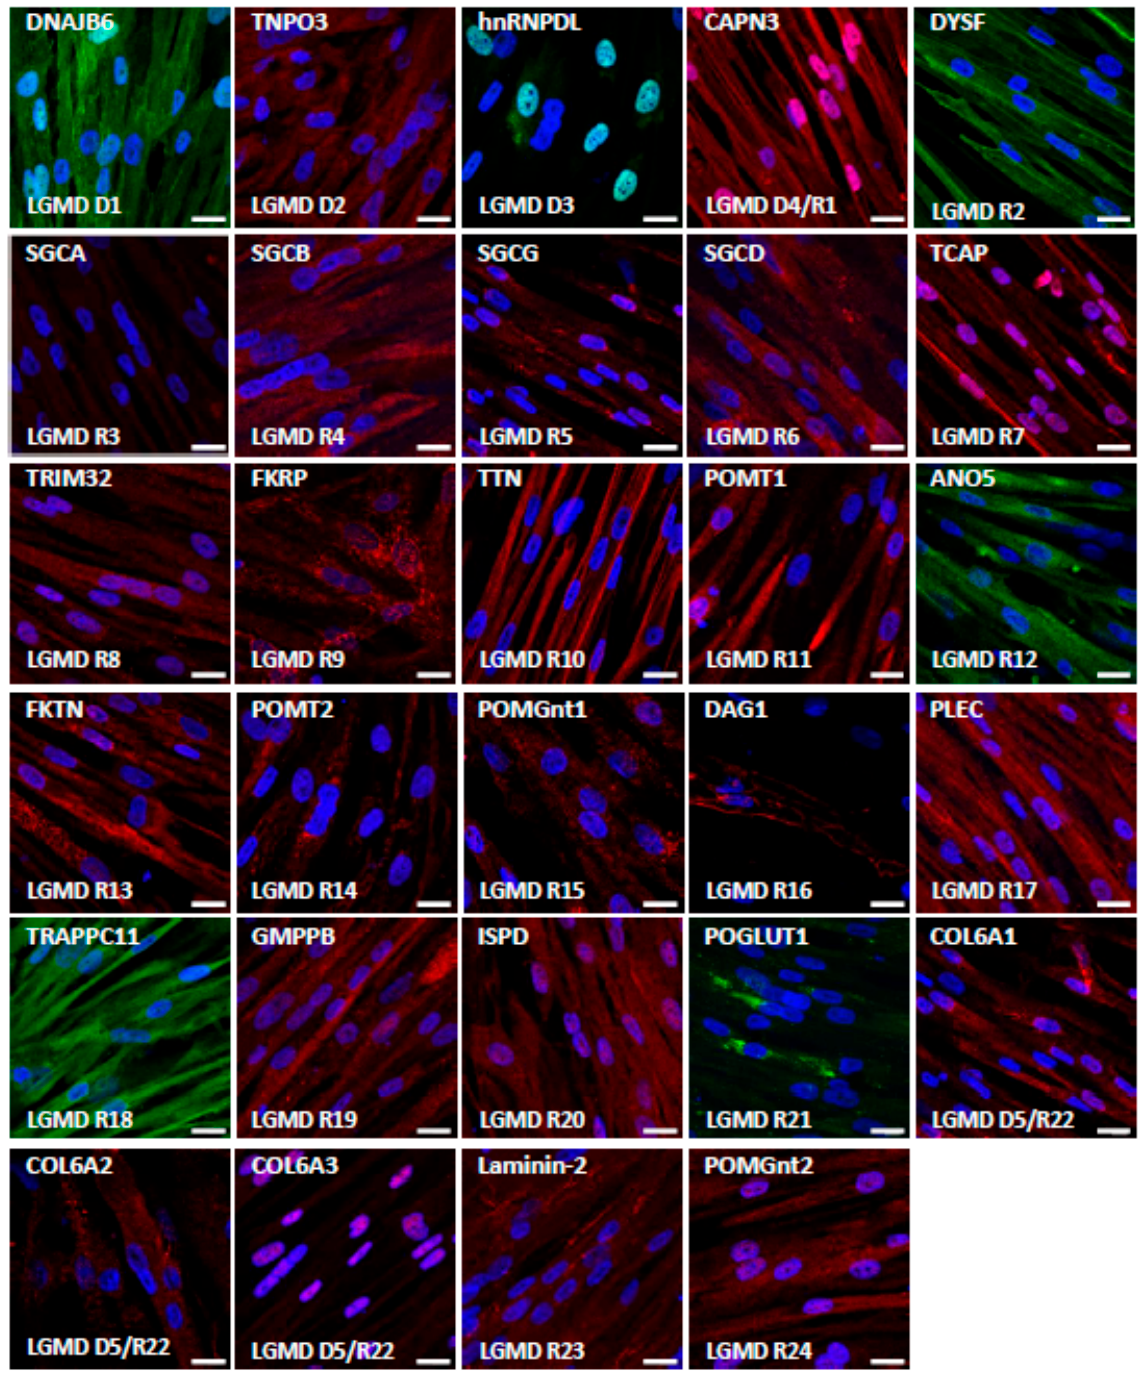
Figure 4. Characterization of LGMD proteins in skMt. Representative images of LGMD protein immunostaining in skMt derived from one control hiPSC line at day 5 of maturation. Nuclei are labeled by Hoechst staining. Scale bar = 20 µ m. Abbreviations: ANO5, anoctamin 5; CAPN3, calpain 3; COL6, collagen 6; DAG1, dystroglycan 1; DNAJB6, DnaJ heat shock protein family member B6; DYSF, dysferlin; FKRP, fukutin-related protein; FKTN, fukutin; GMPPB, GDP-mannose pyrophos- phorylase B; hnRNPDL, heterogeneous nuclear ribonucleoprotein D-like; ISPD, isoprenoid synthase domain-containing protein; LAMA2, laminin subunit alpha 2; PLEC, plectin; POGLUT1, protein O- glucosyltransferase 1; POMGnt, protein O-linked mannose N-acetylglucosaminyltransferase; POMT, protein O-mannosyltransferase; SGC, sarcoglycan; TCAP, titin-cap; TNPO3, transportin 3; TRAPPC11, trafficking protein particle complex subunit 11; TRIM32, tripartite motif-containing 32; TTN, titin.